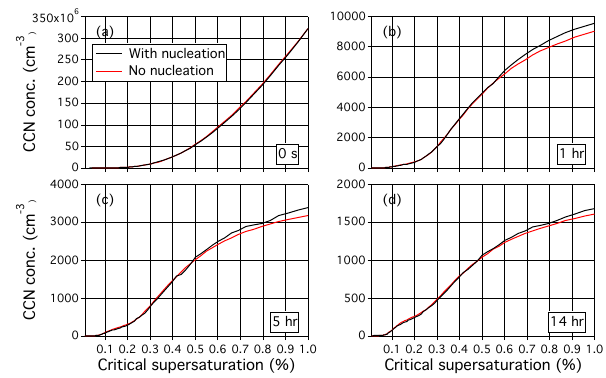
Figure A4. CCN number concentrations as the function of critical supersaturation at 0s, 1h, 5h and 14h for the sensitivity case, com- paring the simulation with nucleation enabled to the simulation with nucleation